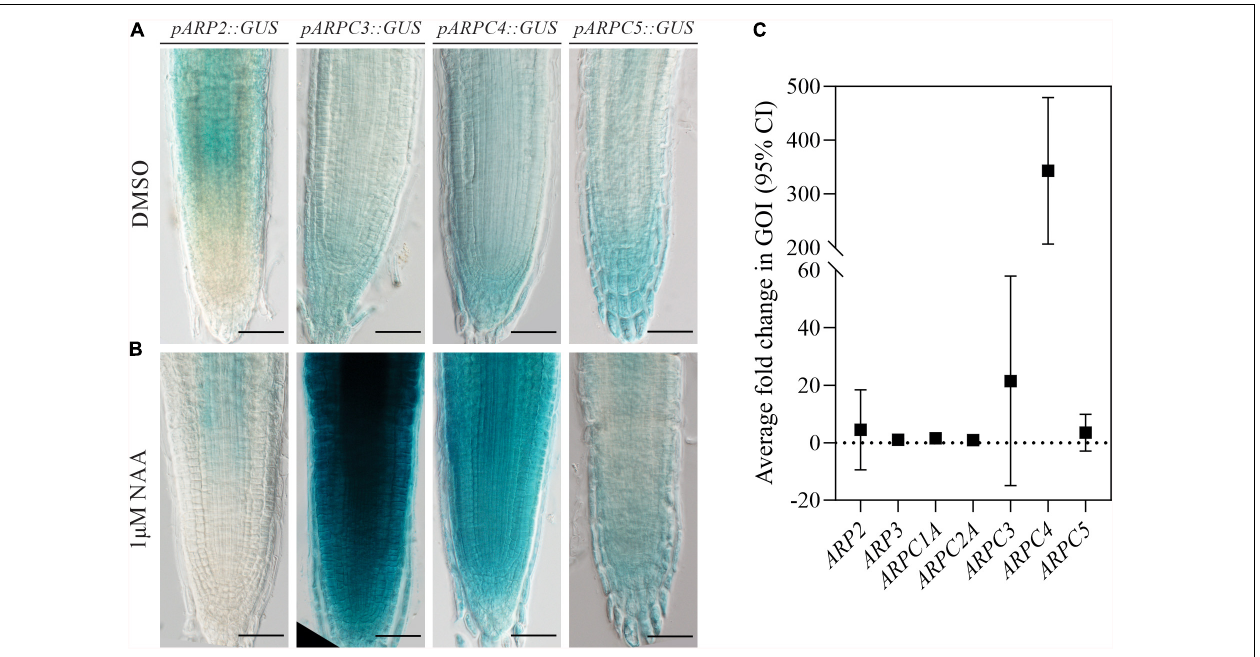
FIGURE 2 | ARP2/3 subunit expression is stimulated by increased auxin levels. Plants expressing the GUS reporter gene under the control of individual ARP2/3 complex subunits’ promoters (pARP2, pARPC3, pARPC4 and pARPC5) were stained for GUS activity after 24-h treatment with 0.1 % DMSO (A) or 1 µ M NAA (B) . (C) Relative transcription levels of individual complex subunits were quantified in five-fay-old YUC1D seedlings by qRT-PCR in three biological replicates. Scale bar = 100 µ